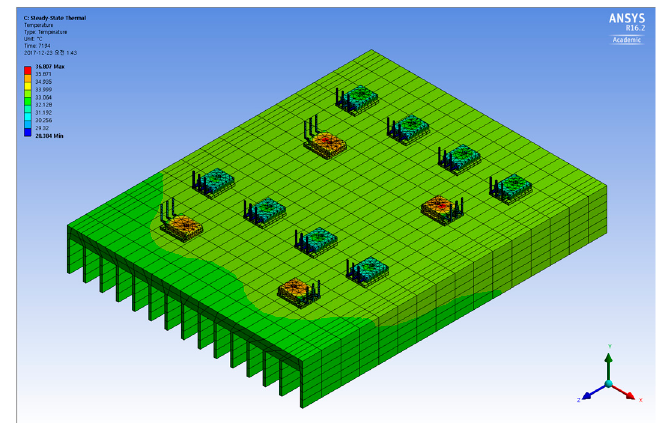
Figure 23. Thermal simulation of the power stage during the operation.